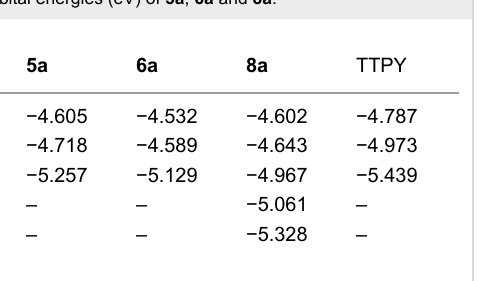
Figure 4: Molecular orbitals of 8a ( trans